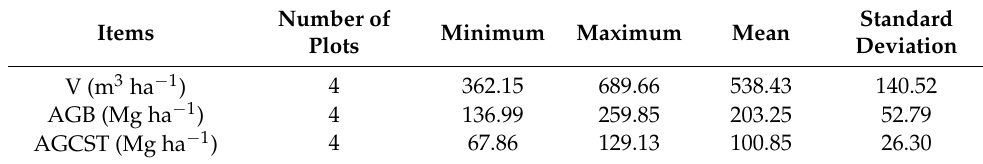
Table 5. The stand volume (V), aboveground biomass accumulation (AGB), and aboveground carbon storage (AGCST) predicted by the diameter distribution model for the Konishii fir plantation.